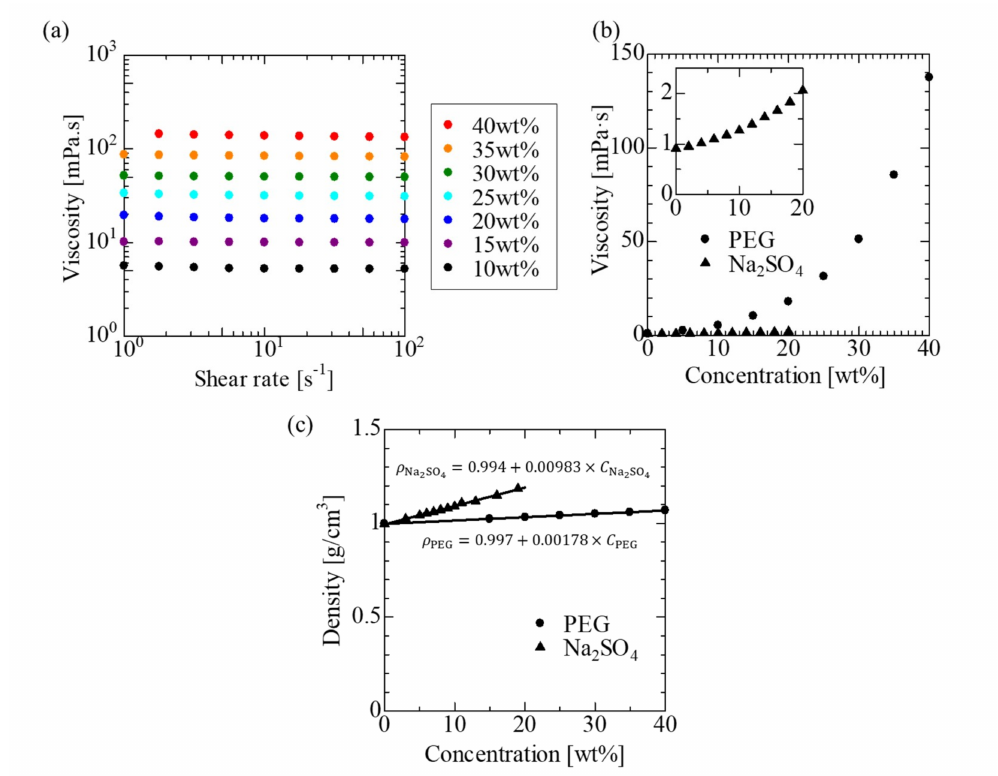
Figure 5. ( a ) Viscosity of PEG solutions against shear rate, ( b ) viscosity of PEG and Na 2 SO 4 solutions against concentration, (inset) viscosity of Na 2 SO 4 solutions against concentrations, ( c ) density of PEG and Na 2 SO 4 solutions against